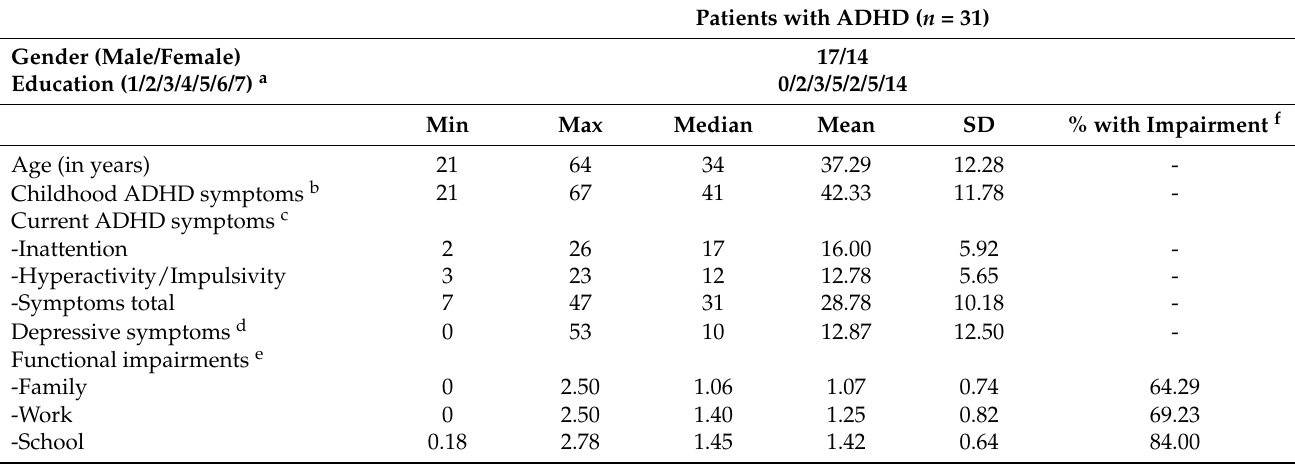
Table 1. Characteristics and symptom scores of patients with